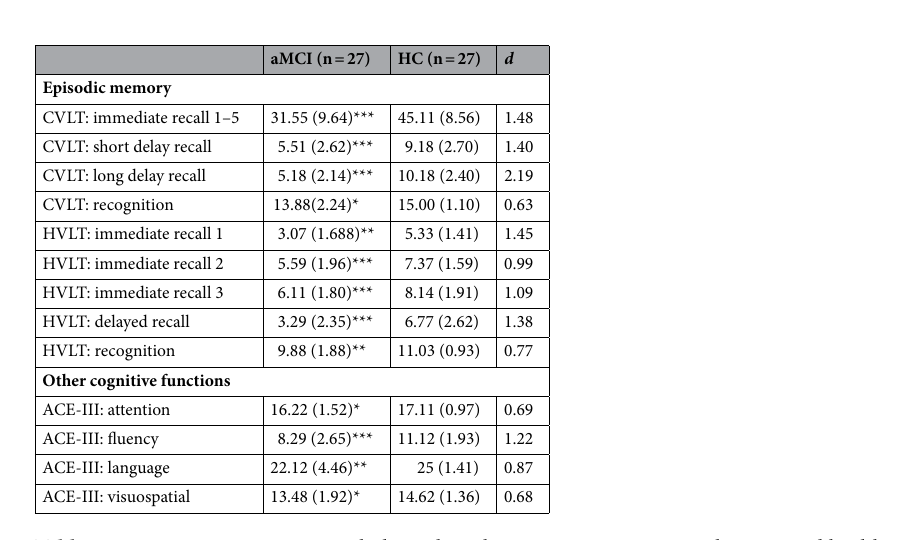
Table 3. Mean scores on neuropsychological test battery in participants with aMCI and healthy controls. For each test, a high score indicates a better performance. aMCI amnestic Mild Cognitive Impairment, HC healthy controls, CVLT California Verbal Learning Test, HVLT Hopkins Verbal Learning Test. Differences between aMCI and HC are indicated by * p < 0.05, ** p < 0.01, *** p < 0.001.